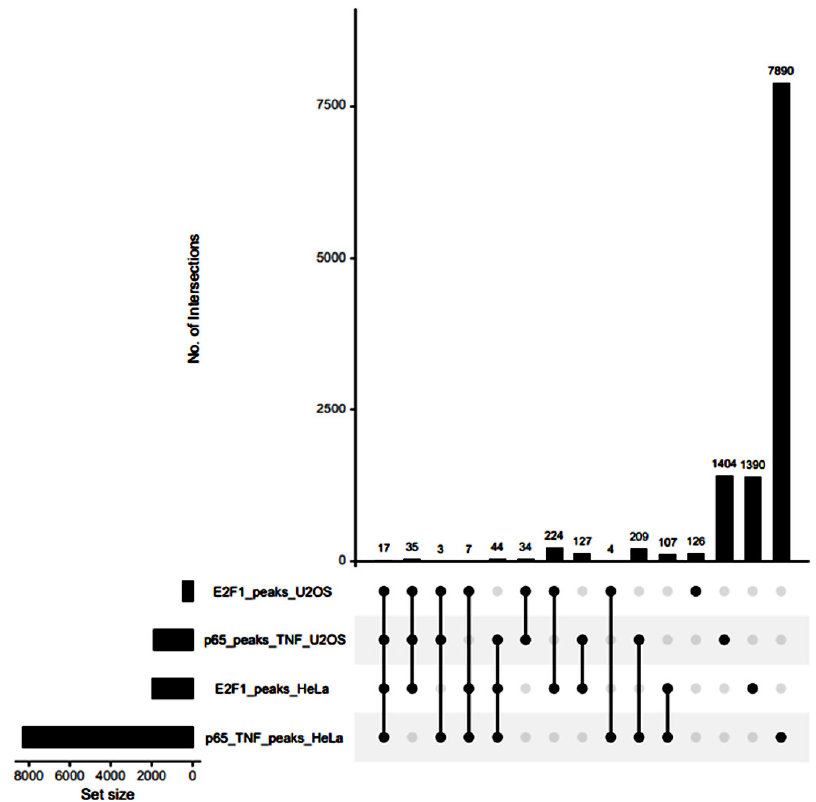
Figure 5. Upset plot showing multi-way comparisons between p65 and E2F1 binding sites in HeLa and U2OS cells.